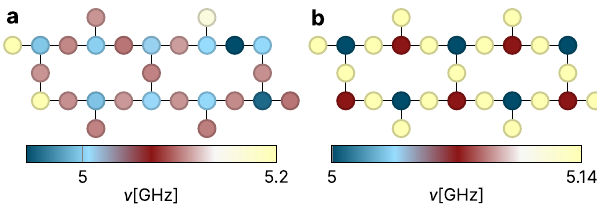
Fig. 7 Frequency alternation patterns. a A-B-A-B pattern. b A-B-A-C pattern optimized for scheme- A architectures on the heavy-hexagon geometry. Note that while b is an idealized structure 12,27 , the A-B pattern of a is one that is currently implemented in experiment 13 , and thus with a slightly imperfect setting of frequencies, visible especially on the far left and right of